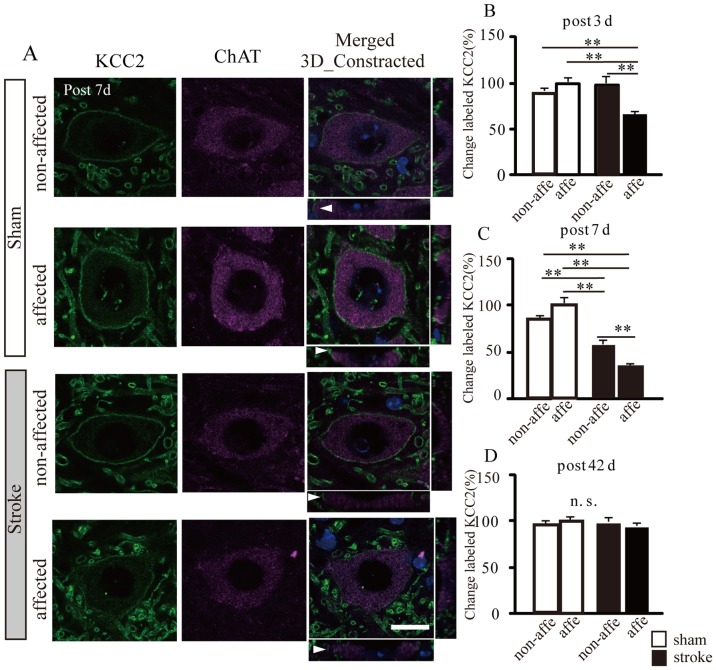
Down-regulation of KCC2 levels using immunohistochemical analysis in motoneuron plasma membrane after stroke.A: Immunofluorescence photomicrographs captured with confocal microscopy showing individual motoneurons labeled with ChAT in magenta, KCC2 in green, and DAPI in blue. Merged image was reconstructed to three dimensional (3D) Z stack images. Arrowheads show the discontinuous labeling of KCC2 in the plasma membrane. Scale bar = 20 “Insert>Symbols” µ m. B-D: Semi-quantification of the density of KCC2 labeling in plasma membranes of spinal motoneurons. Labeled KCC2 is shown as a percentage of the pixel surface per somatic perimeter in the sham-affected side at 3, 7, and 42 d post-stroke, respectively.